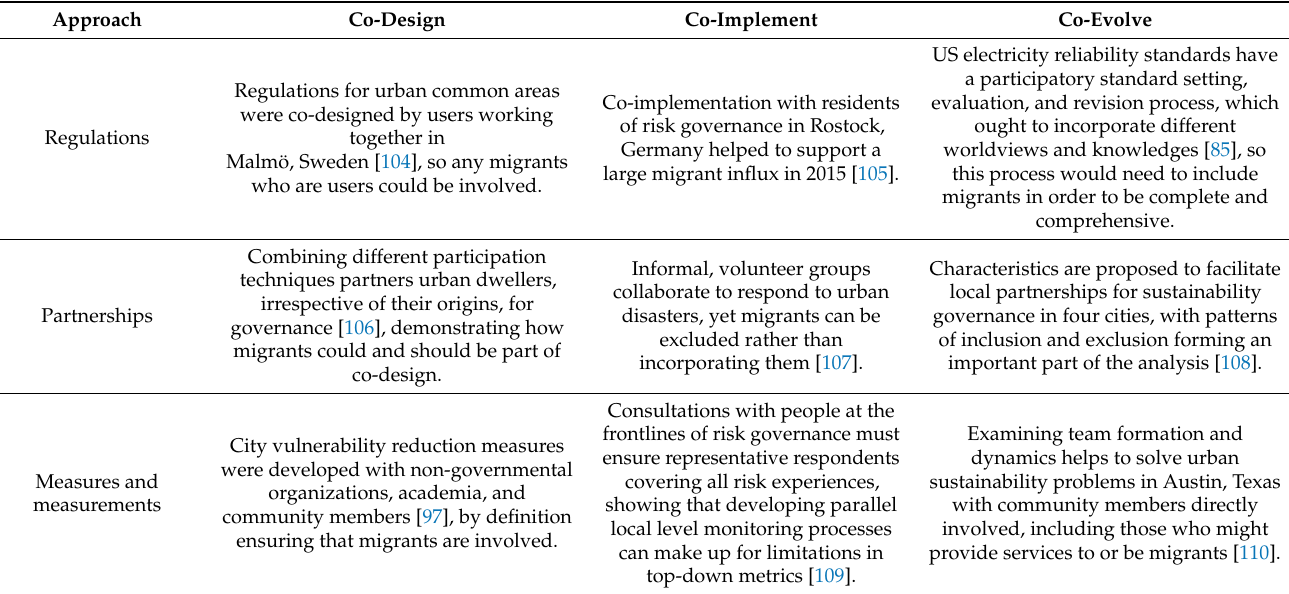
Table 1. Policy and practice approaches for reducing vulnerability and including environmental migrants in sustainable